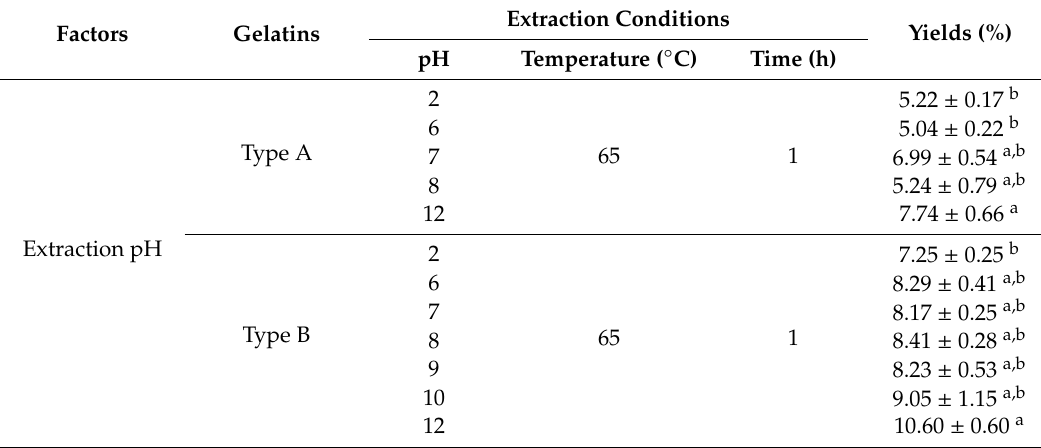
Figure 2. Effects of the extraction pH (2–12) ( a , b ) and extraction temperature (35 °C–65 °C) and time (0.5 h–3 h) ( c , d ) on the intensities of α -, β -, γ -, and low molecular-weight (<100 k) bands of gelatin in the extracts in SDS-PAGE (7.5% gel). Gelatins were extracted from the head skin at different conditions after 0.05 M HCl for 1 h (Type A gelatin) or 0.1 M NaOH for 1 h (Type B gelatin). Each lane contained 1 µL extract. Columns and bars represent means and standard errors of three replicates, respectively. Different letters in each band indicate a significant difference ( p < 0.05). Table 2. Yields (%, dry weight gelatin / wet weight sample) of gelatins extracted from the head skin of Kalamtra sturgeon using di ff erent extraction pH, temperature ( ◦ C), and time (h).